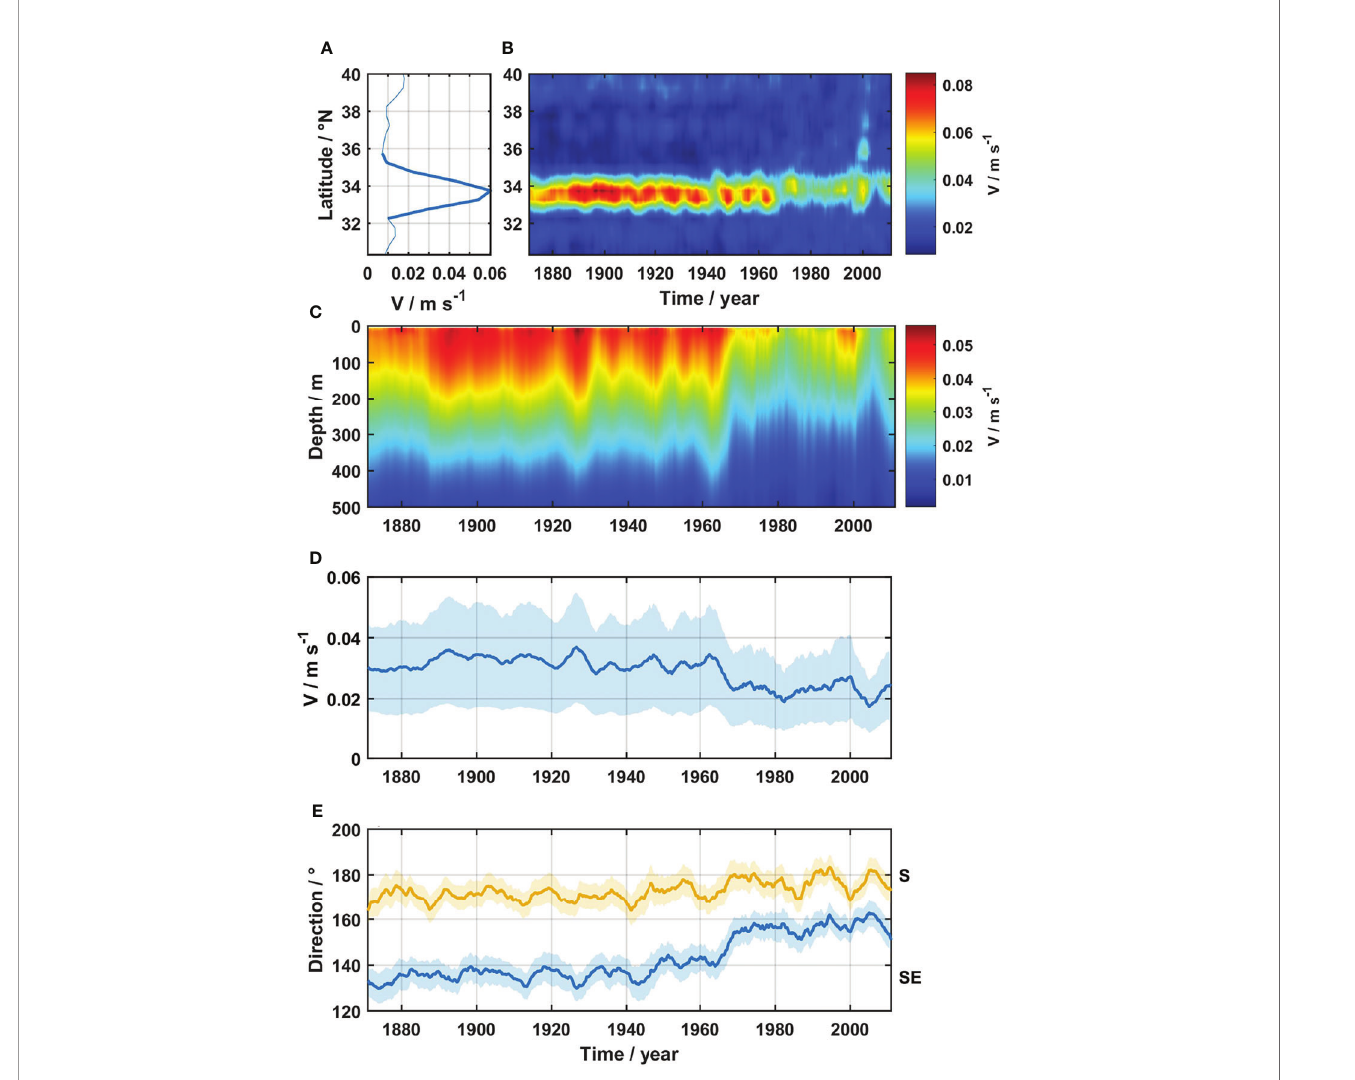
FIGURE 4 | The Azores Current. (A) Average absolute velocity in the upper 1000 m along the Azores Current region (30°N – 40°N, 36°W – 20°W, Fig. 1). A thicker line represents the Azores Current core. (B) Average absolute velocity in the upper 1000 m in the region between 36°W and 20°W for the period 1871 – 2010. Higher velocities between 32° and 36°N indicate the Azores Current jet. (C) Vertical variation of the mean absolute velocity averaged between the core latitudes over the entire period. (D) Time-series of the monthly absolute velocity averaged inside the Azores Current core (A) in the upper 1000 m. Shadowed area is the calculated standard deviation of the absolute velocity in the Azores Current region. (E) Time-series of the Azores Current ’ s average direction in the upper 300 m (solid blue line) and at the layer 300 − 1000 m (solid yellow line) between the latitudes of the Azores Current core (A) . Blue and yellow shadowed areas are the calculated standard deviation of the mean direction fl ow in the upper 300 m and between 300 − 1000 m, respectively. The absolute velocity was calculated from the monthly zonal and meridional velocity fi elds from SODA-POP v2.2.4 (Carton and Giese, 2008; Giese and Ray, 2011). All time-series are smoothed using a 60-months running